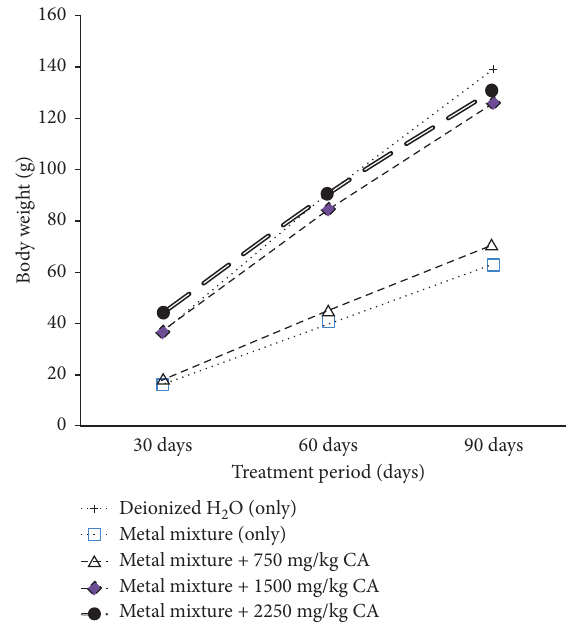
Figure 1: Effect of Costus afer on body weight of male albino rats exposed to heavy metal